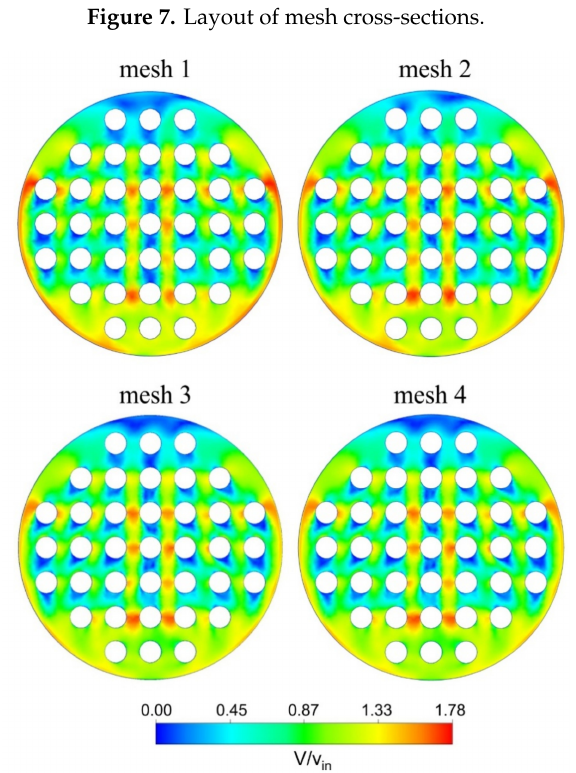
Figure 8. Velocity contours for analyzed geometric